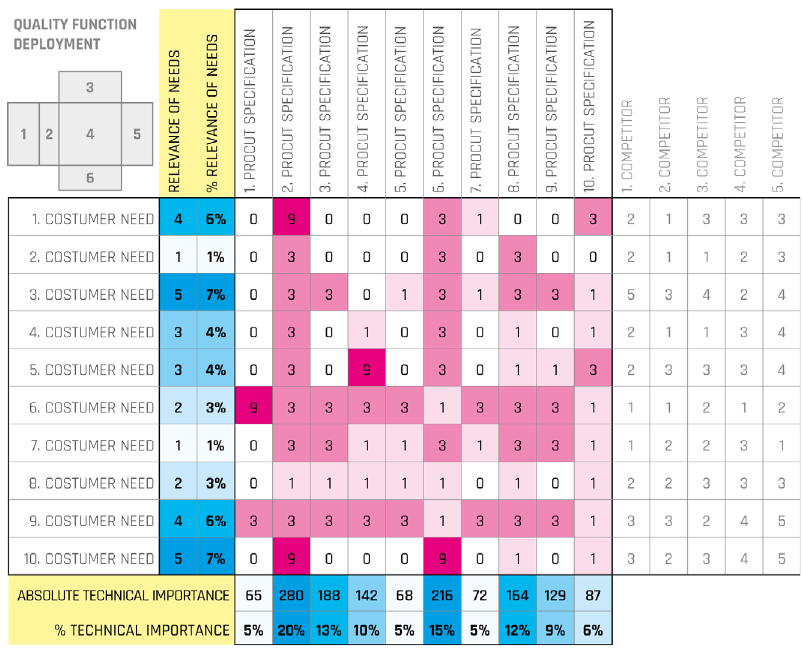
FIG. 1 An example of a QFD matrix. Source: S. Imbesi,